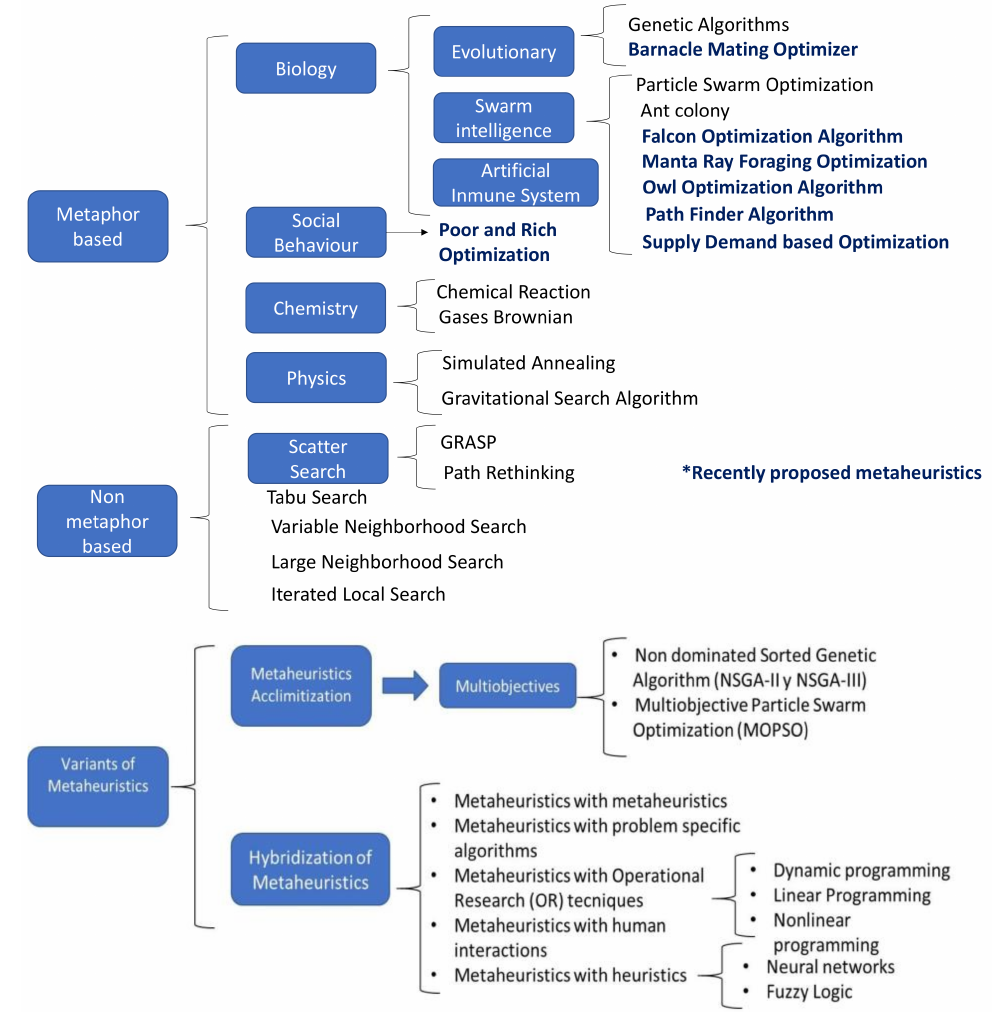
Figure 5. Metaheuristic classification, based on Abdel-Basset et al.